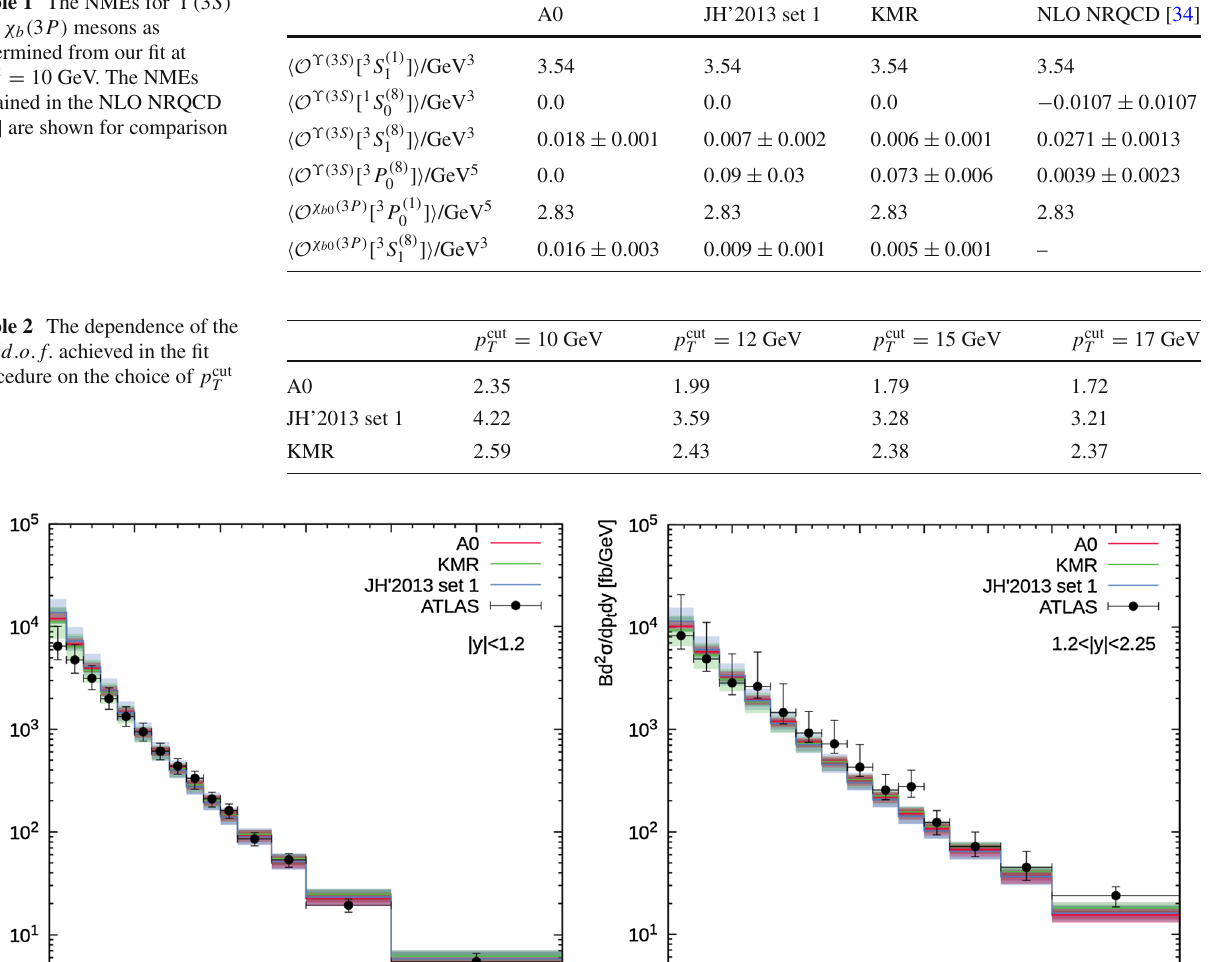
Table 1 The NMEs for ϒ( 3 S ) and χ b ( 3 P ) mesons as determined from our fit at p cut